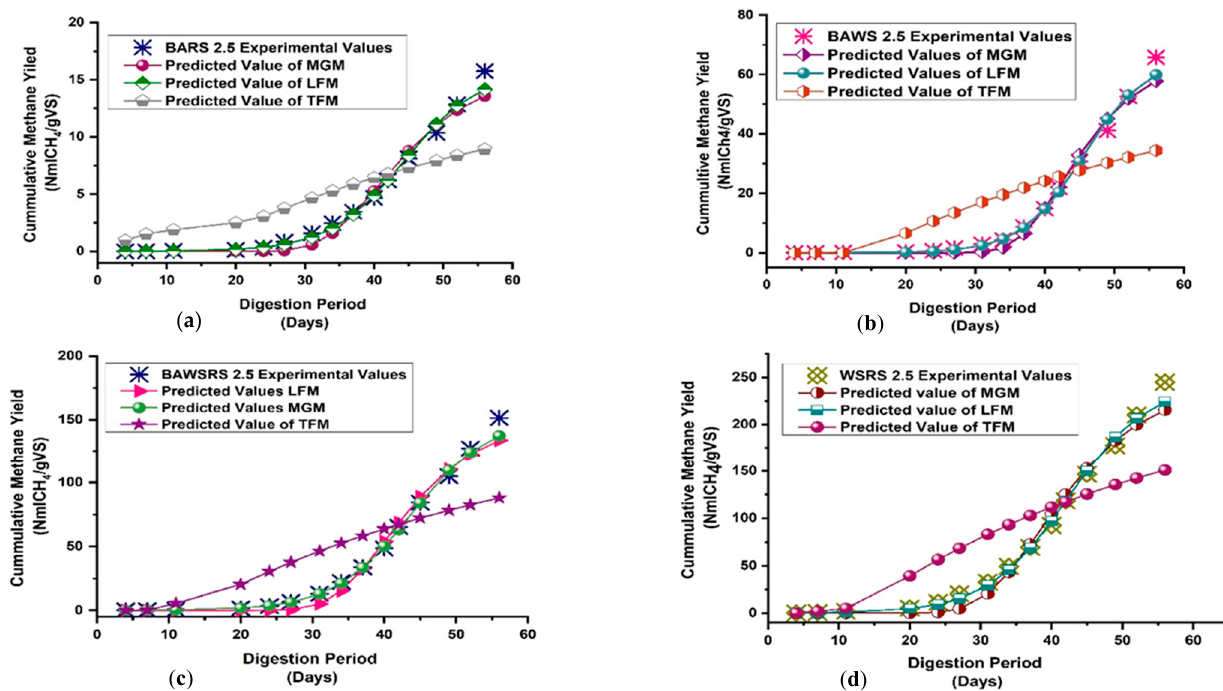
Figure 5. Cumulative Methane Production–Experimental; Transference, Logistic and Modified Gompertz Model for Reactors ( a ) Baggase and Rice straw(BARS), ( b ) Baggase and Wheat Straw (BAWS) ( c ) Baggase, Wheat straw and Rice starw (BAWSRS), ( d ) Wheat straw and Rice Straw (WSRS) with S/I 2.5.